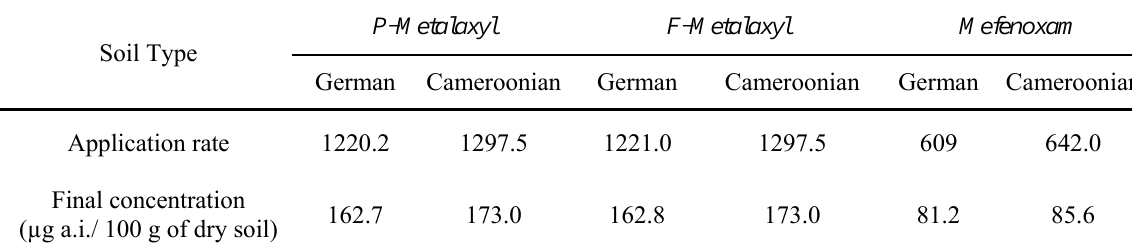
Table 2: Rates of application and measured final concentration of the investigated fungicides in soils a